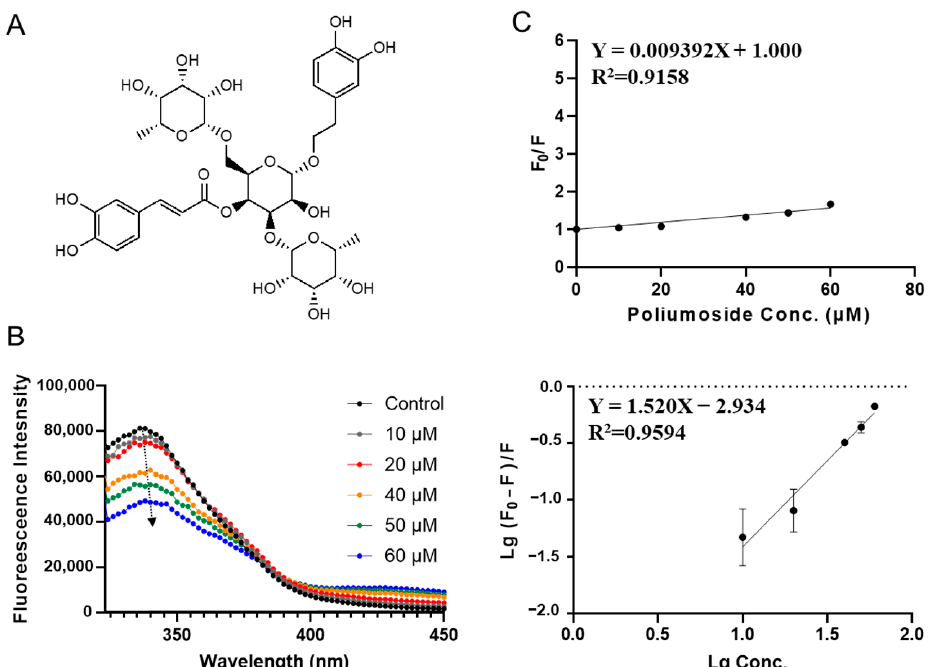
Figure 5. Characterization of SPI–poliumoside interaction by fluorescence quenching assay. ( A ) Molecular chemical structure of poliumoside. ( B ) The fluorescence emission spectra of SPI titrated with different concentrations of poliumoside (10, 20, 40, 50, 60, µ M). ( C ) The Stern–Volmer plots for binding parameter calculation.